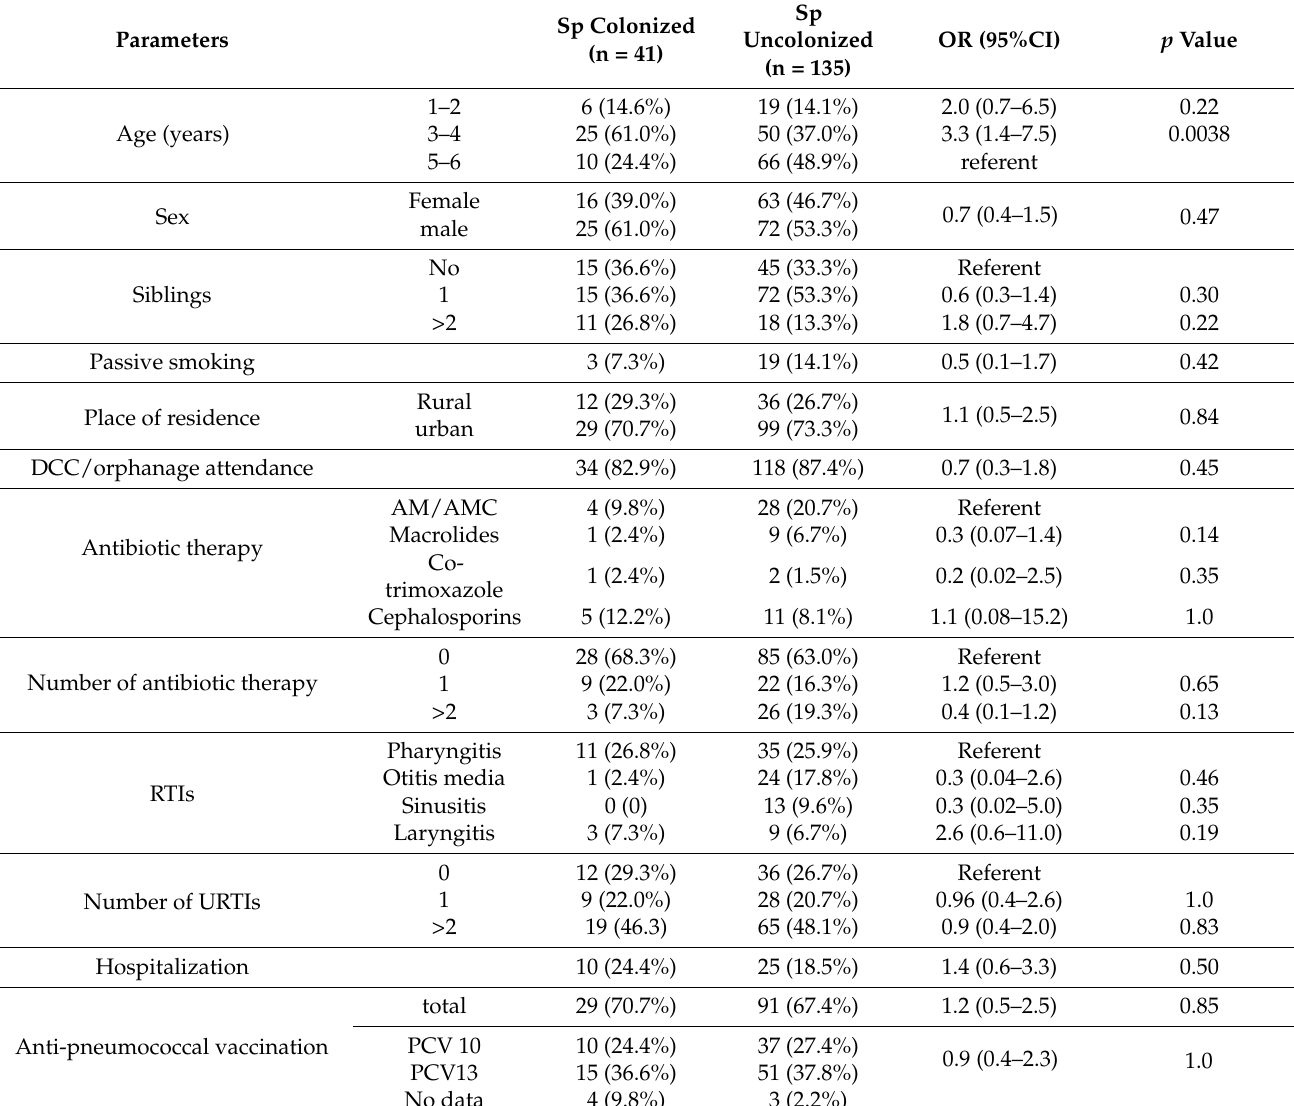
Table 1. Demographic and clinical characteristics of 176 healthy